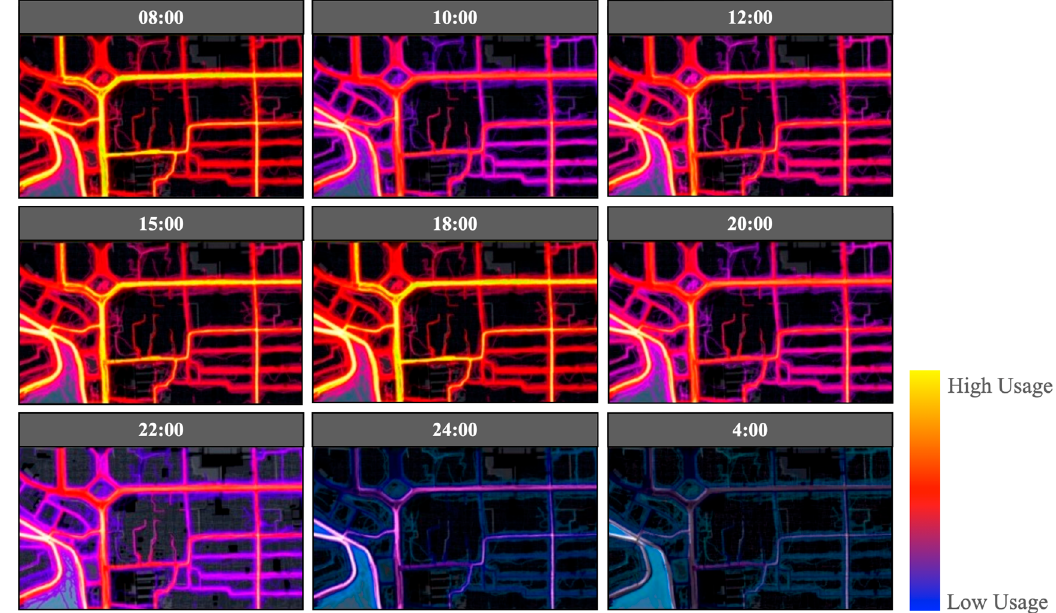
Figure 5. Pedestrian movement at different times of day.